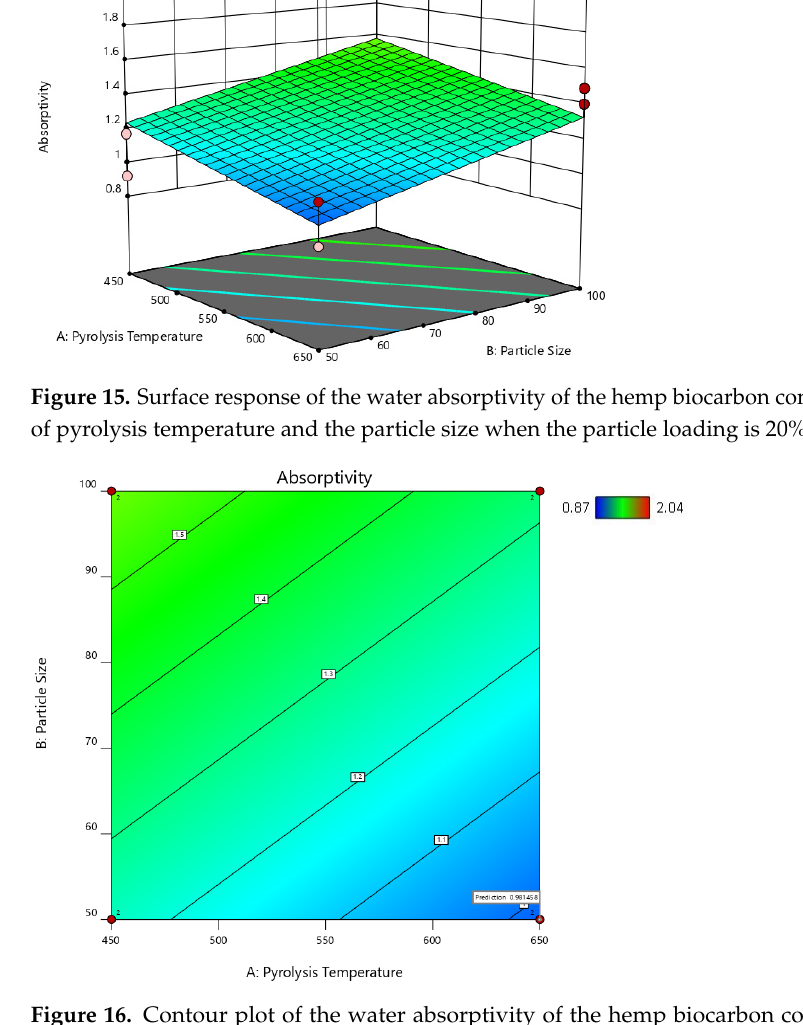
Figure 16. Contour plot of the water absorptivity of the hemp biocarbon composites against the particle size and the pyrolysis temperature when the filler loading is 20%.